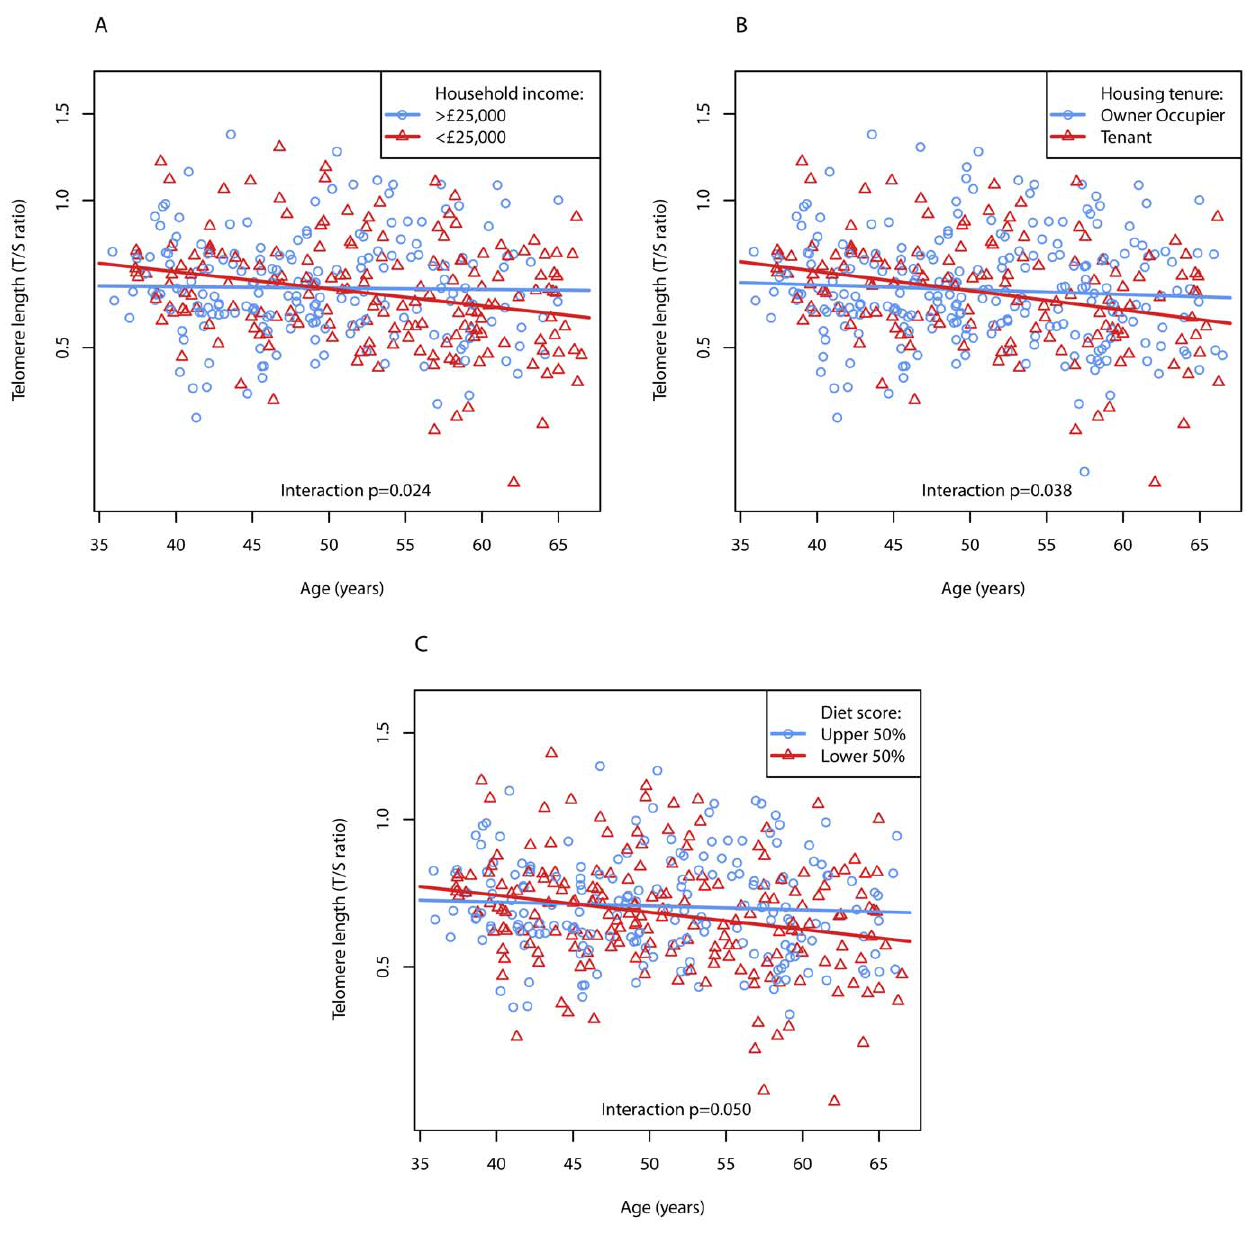
Figure 1. Regression analysis plots that highlight household income, housing tenure, and diet score were associated with steeper age-related decline in telomere length. Faster rates of age-related telomere attrition were observed in individuals with an average income less than £25,000 (7.7% vs 0.6% reduction per decade, p=0.024, (A)), home tenants (8.7% vs 2.2%, p=0.038 (B)) and a diet score among the lower 50% of scores (7.7% vs 1.8%, p=0.05 (C)).